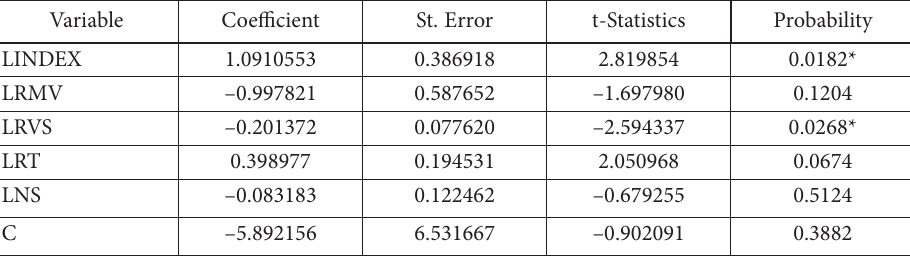
Table 8. Long run estimates with dependent variable LPGDP